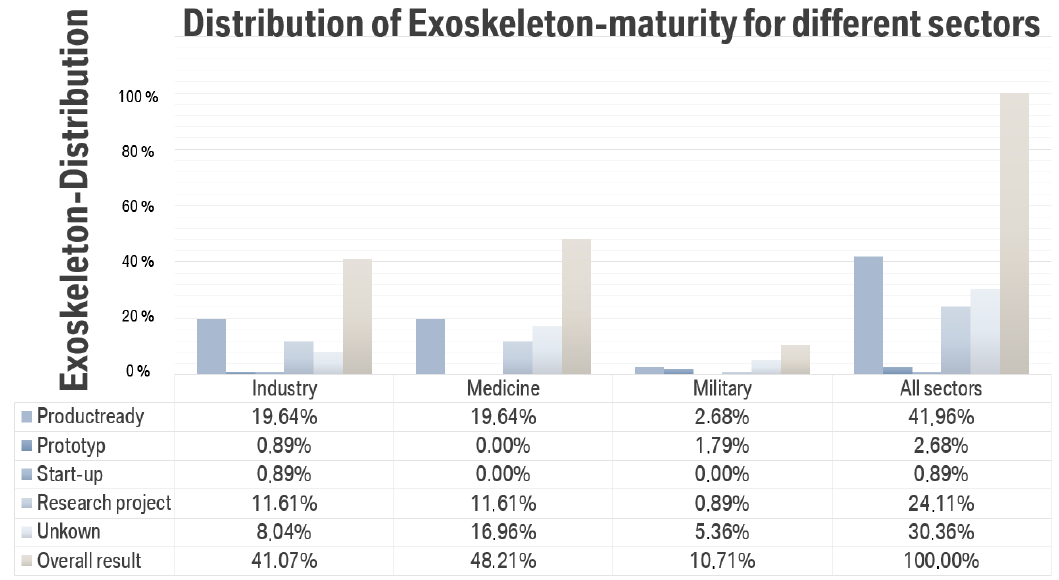
Figure 2. Overview and statistic from state of exoskeleton maturity on each sector © [1].